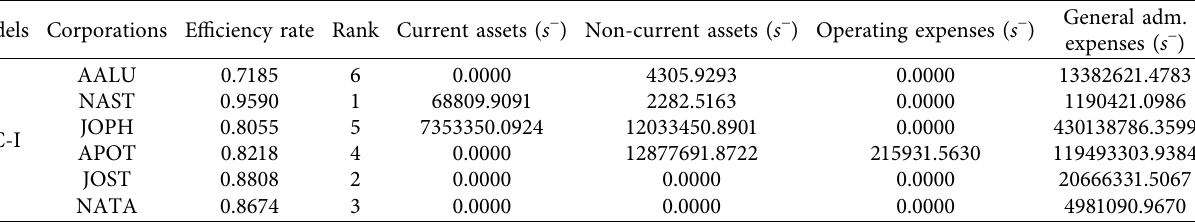
Table 7: The average efficiency rate and slacks for BCC-I during